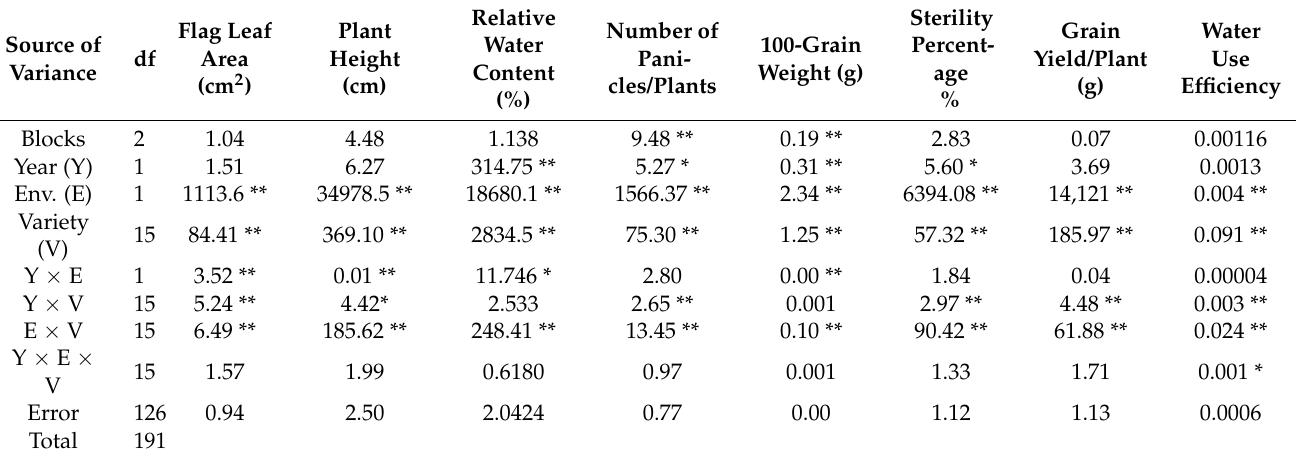
Table 5. Analysis of variance for grain yield and related traits under normal and drought in 2018 and 2019 rice growing seasons.